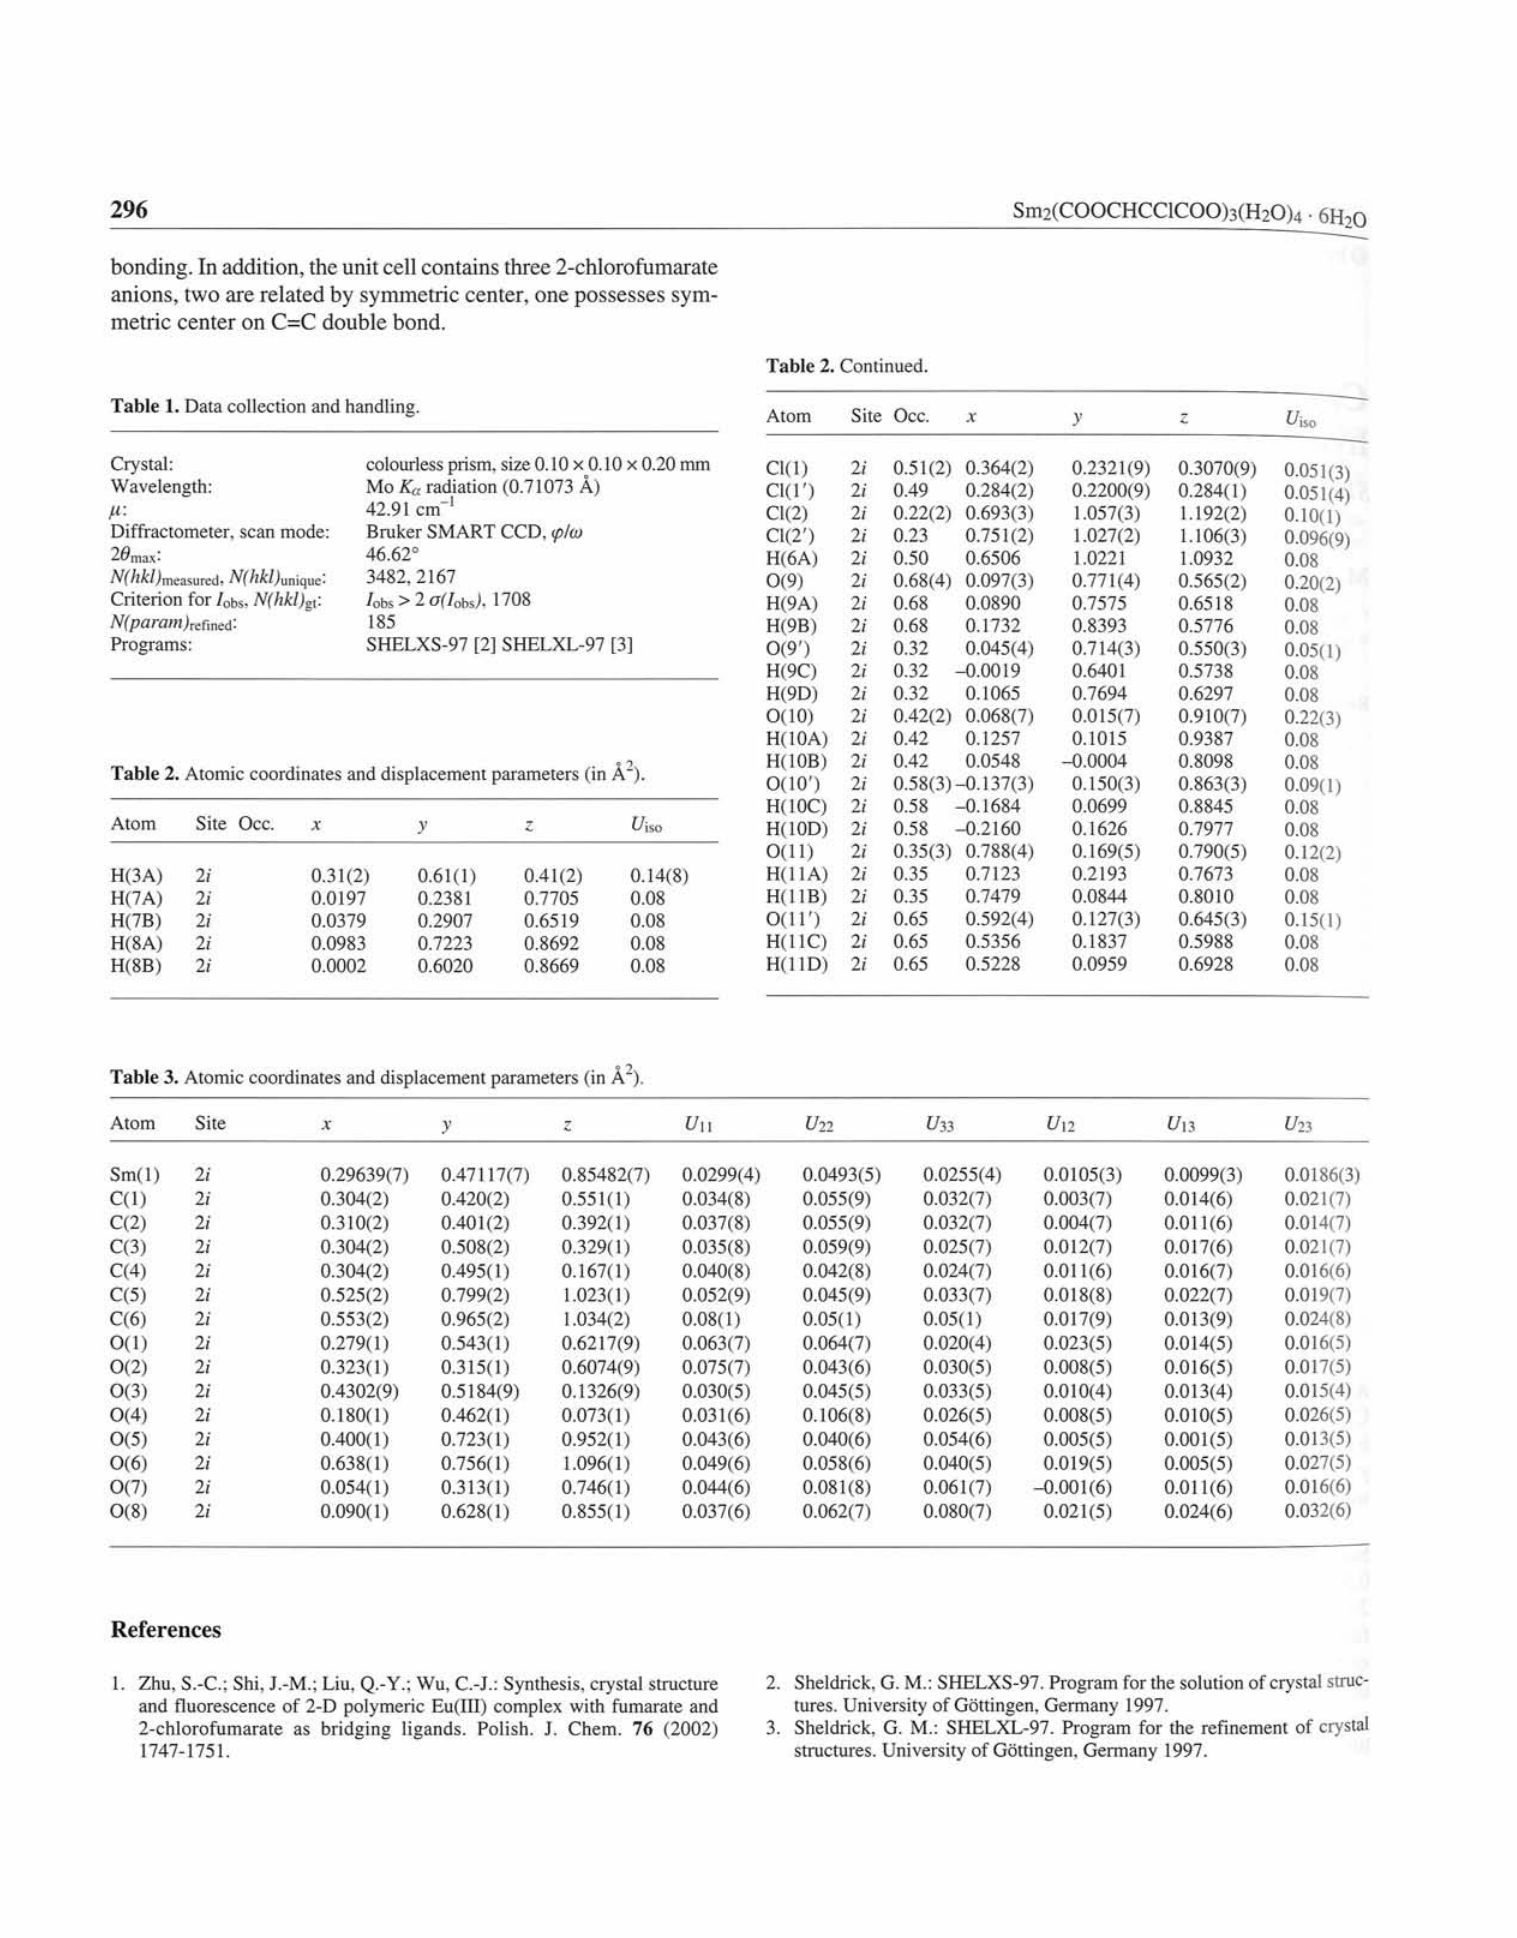
Table 2. Atomic coordinates and displacement parameters (in A").